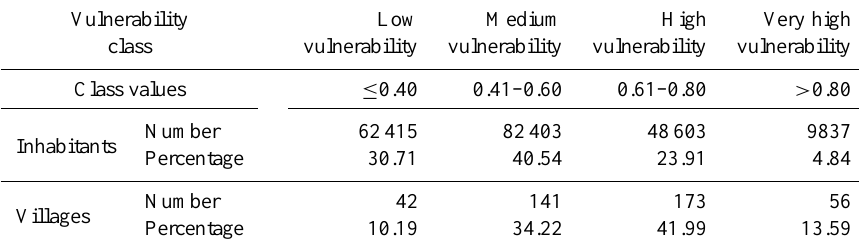
Table 7. Synthetic data on vulnerability in Tutova